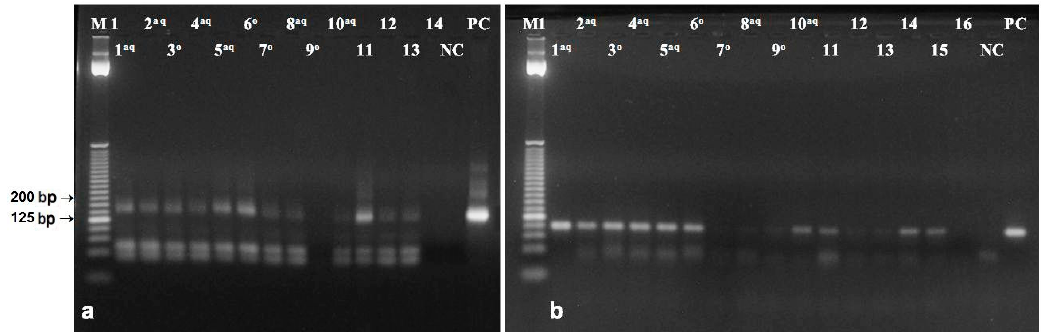
Figure 6. Agarose gel electrophoresis of PCR products obtained by amplification of 156 bp microsatellite psSSR69 ( a ) and 96 bp fragment of reference tubulin gene ( b ). M1—25 bp DNA ladder (Invitrogen). DNA extracted by Consolandi et al. [30] (lines 1–6) from 3 mL (1–3) or 6 mL (4–6) of oil, Raieta et al. [4] (lanes 7–10) from 3 mL (lanes 7,8) or 1 mL (lanes 9–10) oil, Doveri et al. [29] (line 11) extracted from 1 mL of oil, Giménez et al. [31] (lines 12–13) extracted from 0.5 mL (lane 12) or 3 mL (lane 13) of oil, QIAamp DNA Stool Mini Kit (lanes 14–16) extracted from 0.2 mL (lane 14b), 1 mL (lane 15b) or 15 mL (lanes 14a and 16b) of oil, NC—negative control, PC—positive control. aq/o —DNA from water ( aq ) or oily ( o ) phase.